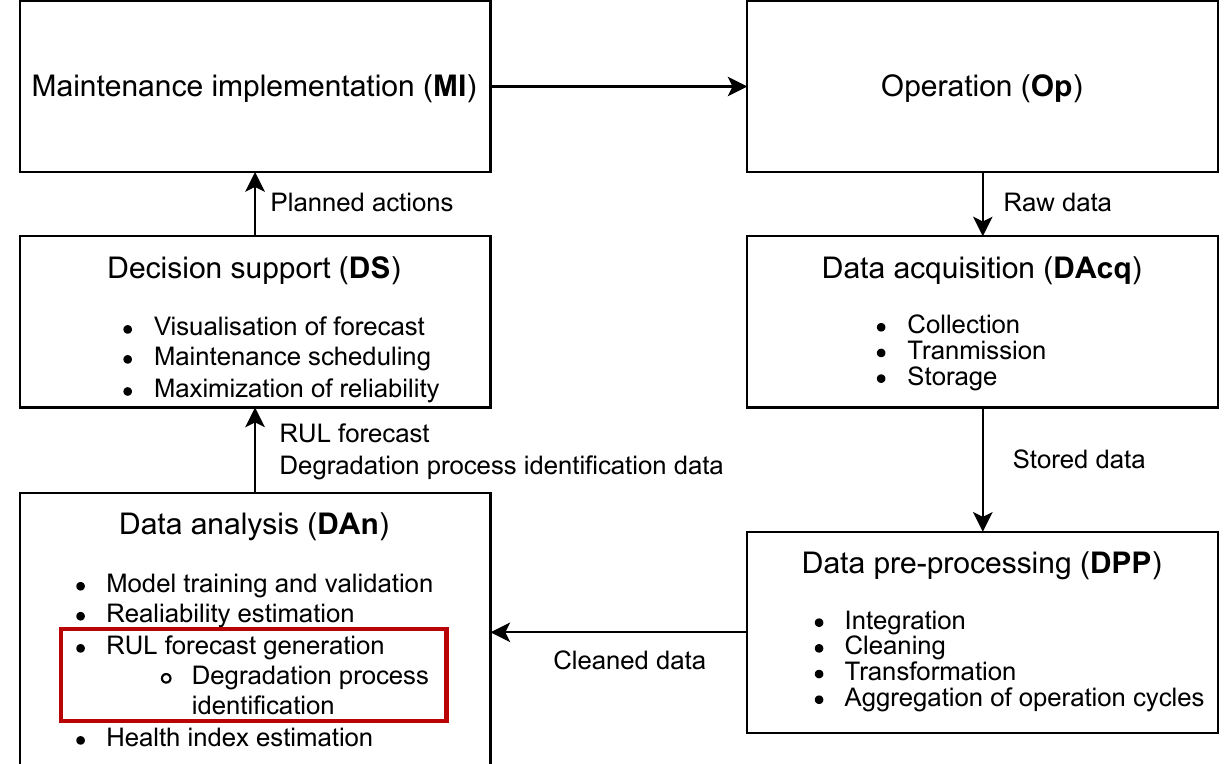
Figure 2. Flowchart of the entire predictive maintenance methodology (adapted from